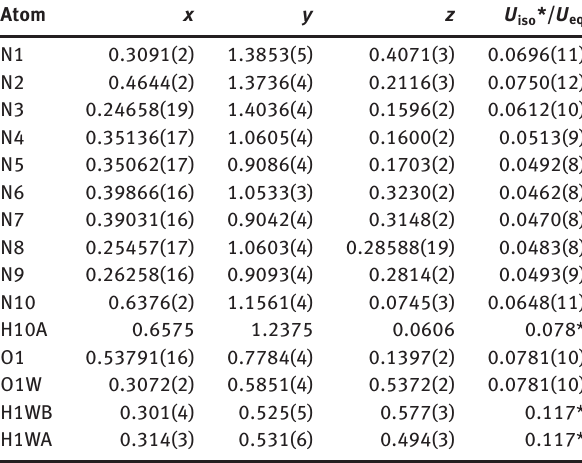
Table 2: Fractional atomic coordinates and isotropic or equivalent isotropic displacement parameters (Å 2